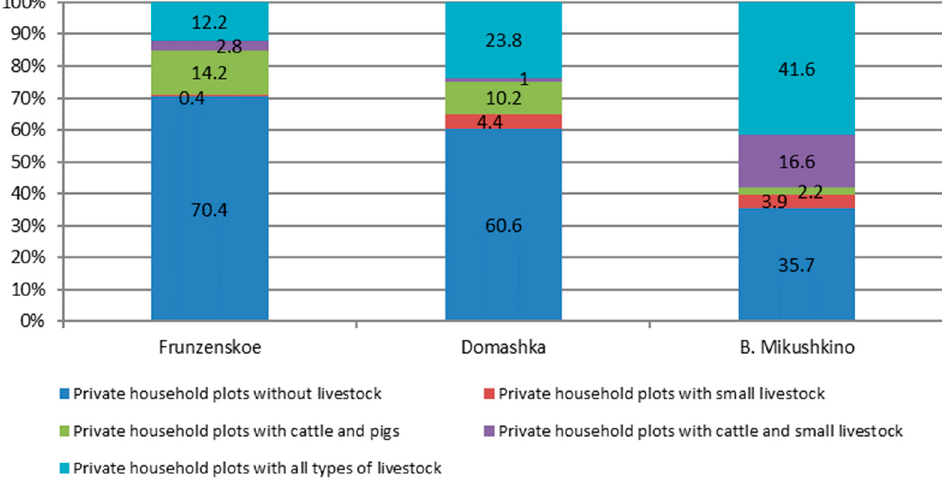
Figure 10. Comparison of private household plots by livestock.